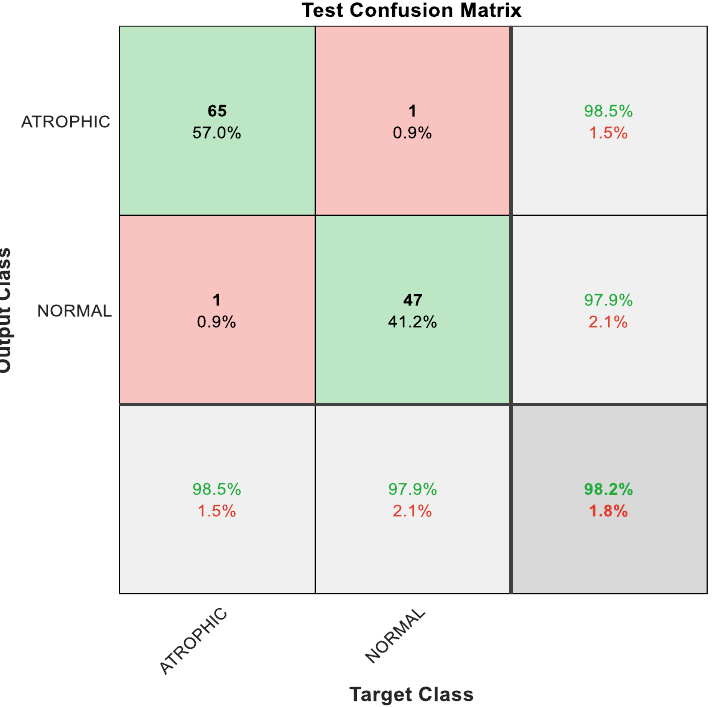
Figure 7. Confusion matrix with results analyzed from the testing data executed via hybrid model and classified by GAM. and classified by